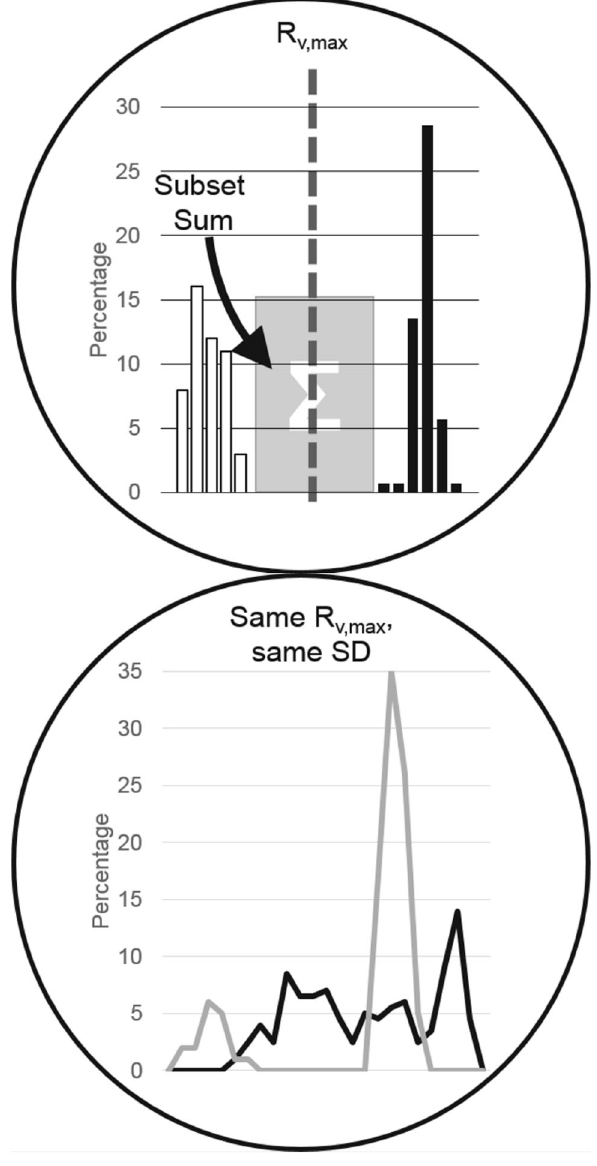
Fig. 1 Demonstration of the limitations of existing characterizations of vitrinite reflectance in determination of the modality of distribu- tions, with both distributions shown having the same mean R v,max and